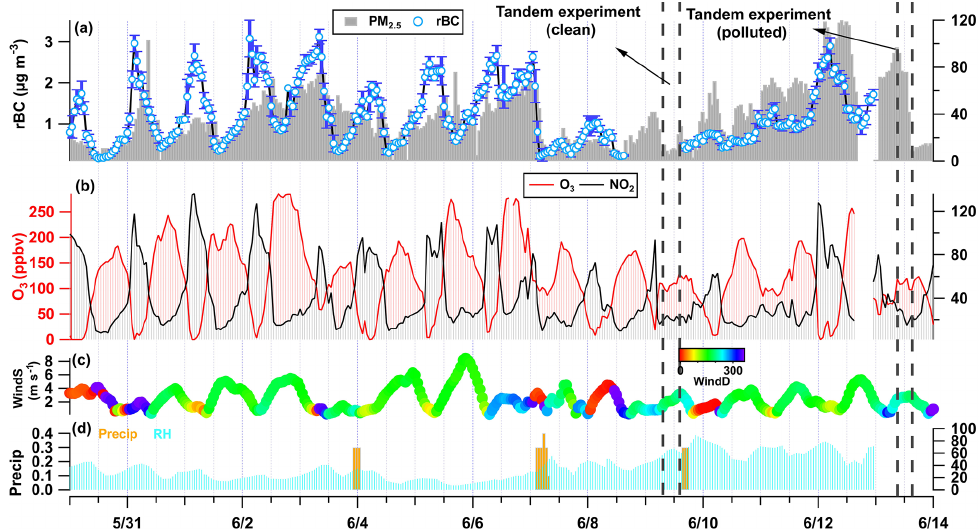
Figure 3. Time series of aerosol/gaseous pollutants and meteorological conditions during the observation period.